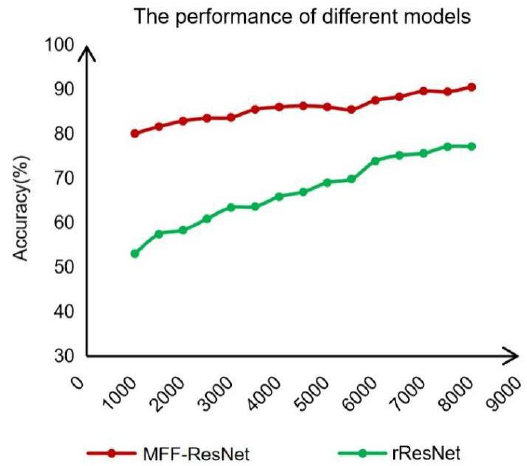
Figure 13. Contrast experiment with different numbers of training samples.